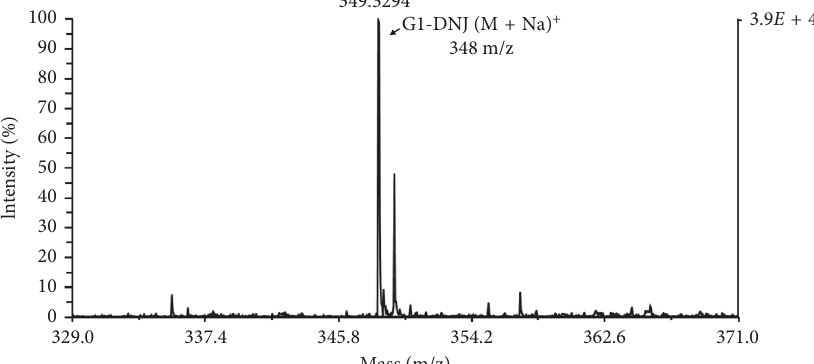
Figure 6: Matrix-assisted laser desorption/ionization time-of-flight (MALDI-TOF) mass spectrum of the DNJ transglycosylation product. The purified glycosylation transfer product was determined using MALDI-TOF mass spectrometry. The molecular weight of the glucoside was one glucose residue larger than that of DNJ. G1-DNJ was observed at m / z 348.3294 (M+Na) + .